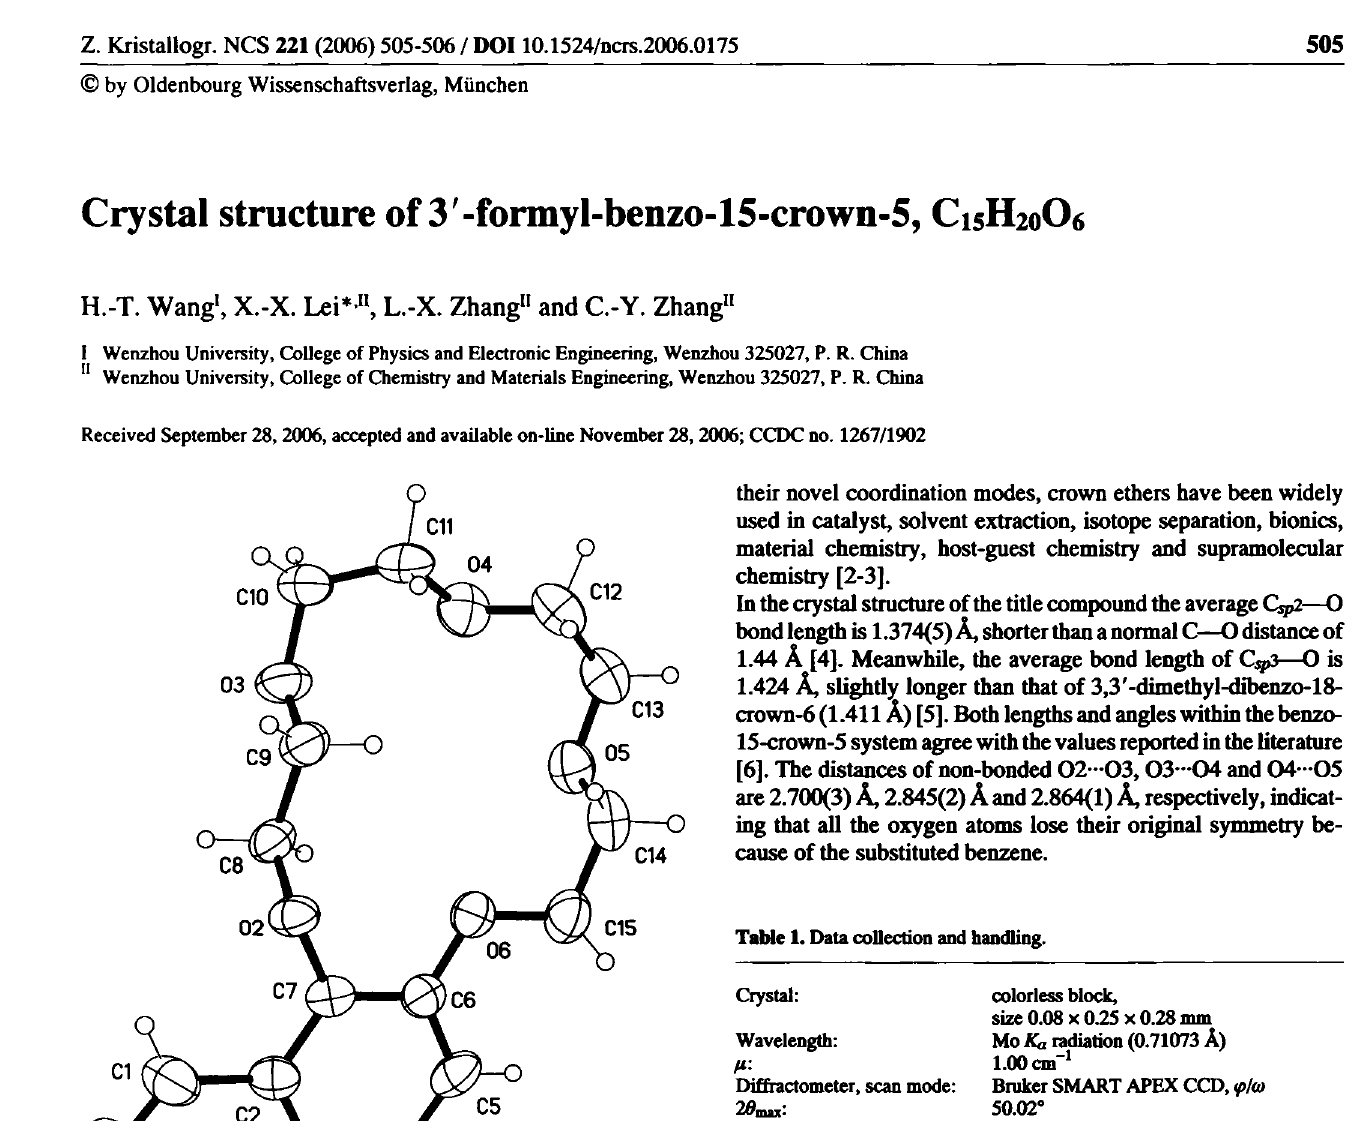
Table 2. Atomic coordinates and displacement parameters (in A 2